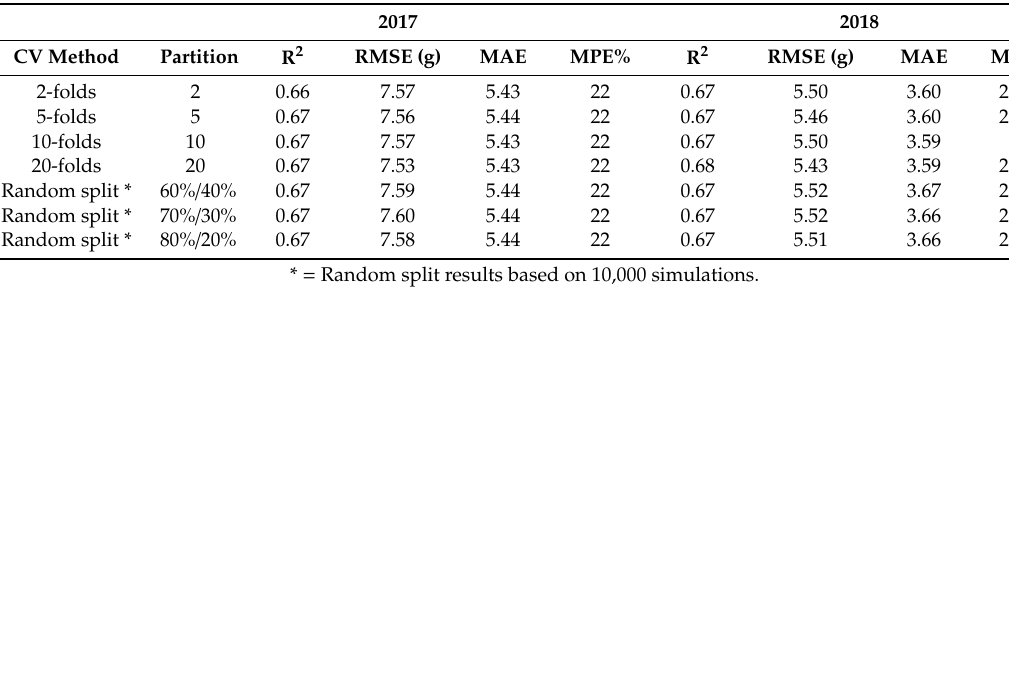
Table 4. Summary of cross-validation results for dry herbage yield (g / p). CV method: cross-validation method; RMSE: root mean square error; R 2 : coe ffi cient of determination; MAE: mean absolute error; MPE: mean percentage